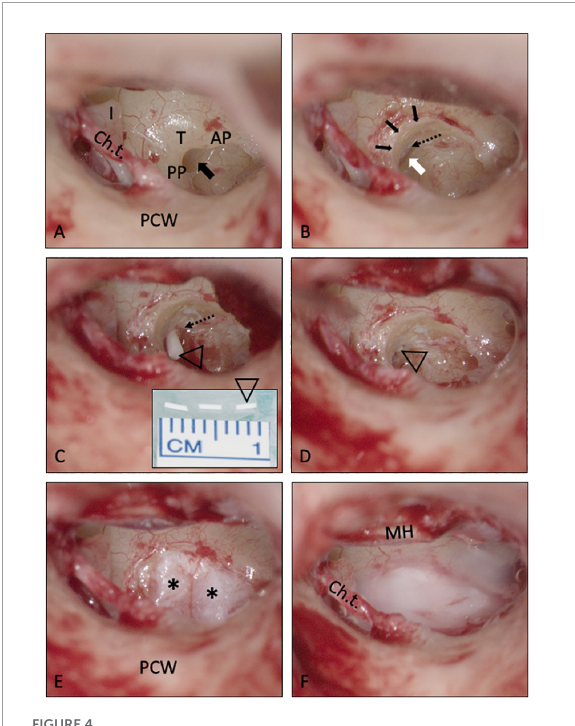
FIGURE4 Intracochlear application of a solid biodegradable drug delivery system through the RW into scala tympani. (A,B) The RWM is usually hidden in the depth of the RW niche [black arrow in A ; mean depth: 1.34 mm, range: 0.69–2.28 mm, (Su et al., 1982)]. To insert the drug delivery devise into scala tympani, the RWM (white arrow) was exposed by removing the bony rim of the RW niche [small black arrows in panel (B) ], i.e., the tegmen (T), the anterior postis (AP) and partially also the posterior postis (PP). The RWM was opened, and the drug delivery system [open triangle in panels (C,D) ] was gently pushed into the scala tympani with an otologic needle or hook. It was not necessary, to remove the crest of the RW, a thin vertical bony plate about 0.5 mm in height at the anterior border of the RW extending into scala tympani [dashed arrow in panels (B,C) ]. The RW defect was sealed by covering the RW niche with soft tissue [ ∗ in panel (E) ] and fibrin glue (F) . See also Supplementary video material . Ch.t.: Chorda tympani; I: long process of incus; MH: malleus handle; PCW: posterior canal